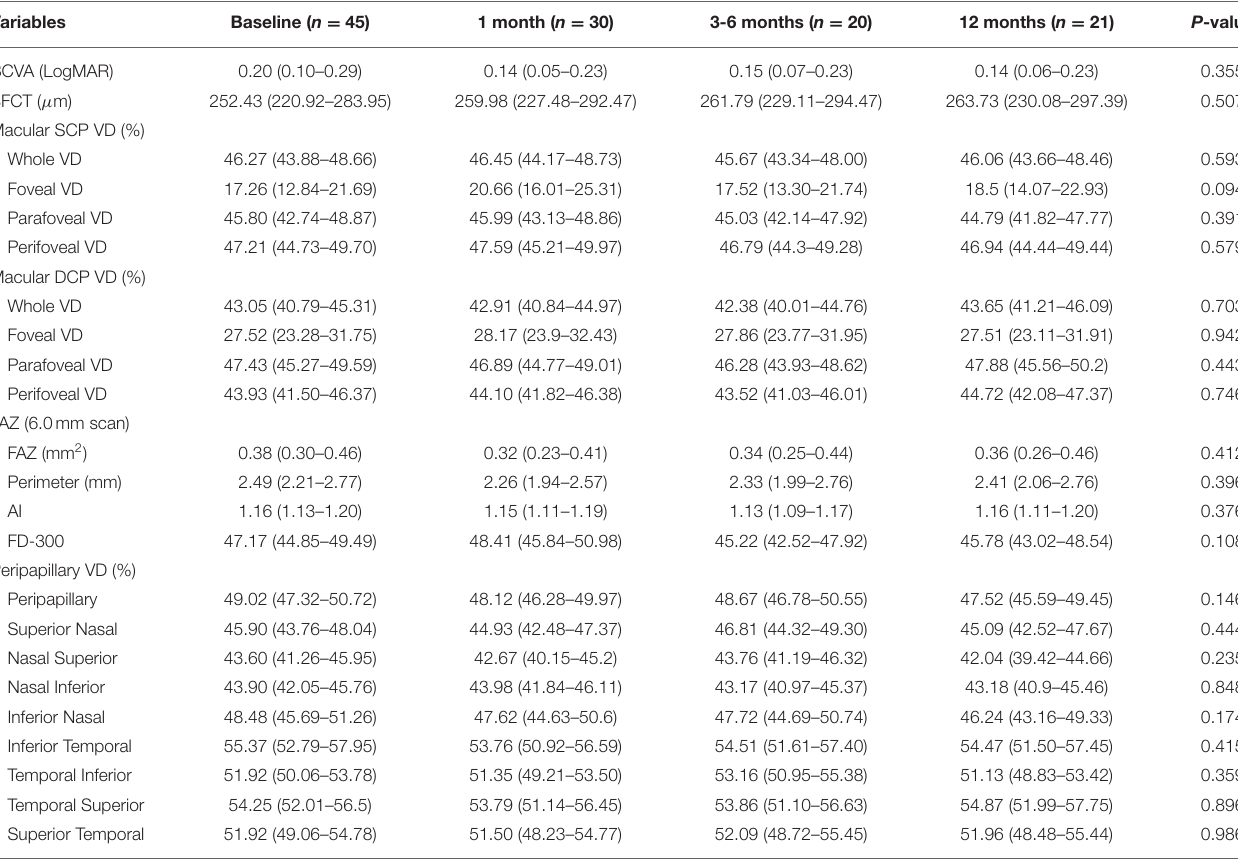
TABLE 2 | Longitudinal changes of the best corrected visual acuity (BCVA), subfoveal choroidal thickness (SFCT), macular vessel density, and foveal avascular zone (FAZ) after panretinal photocoagulation [mean (95% CI)].